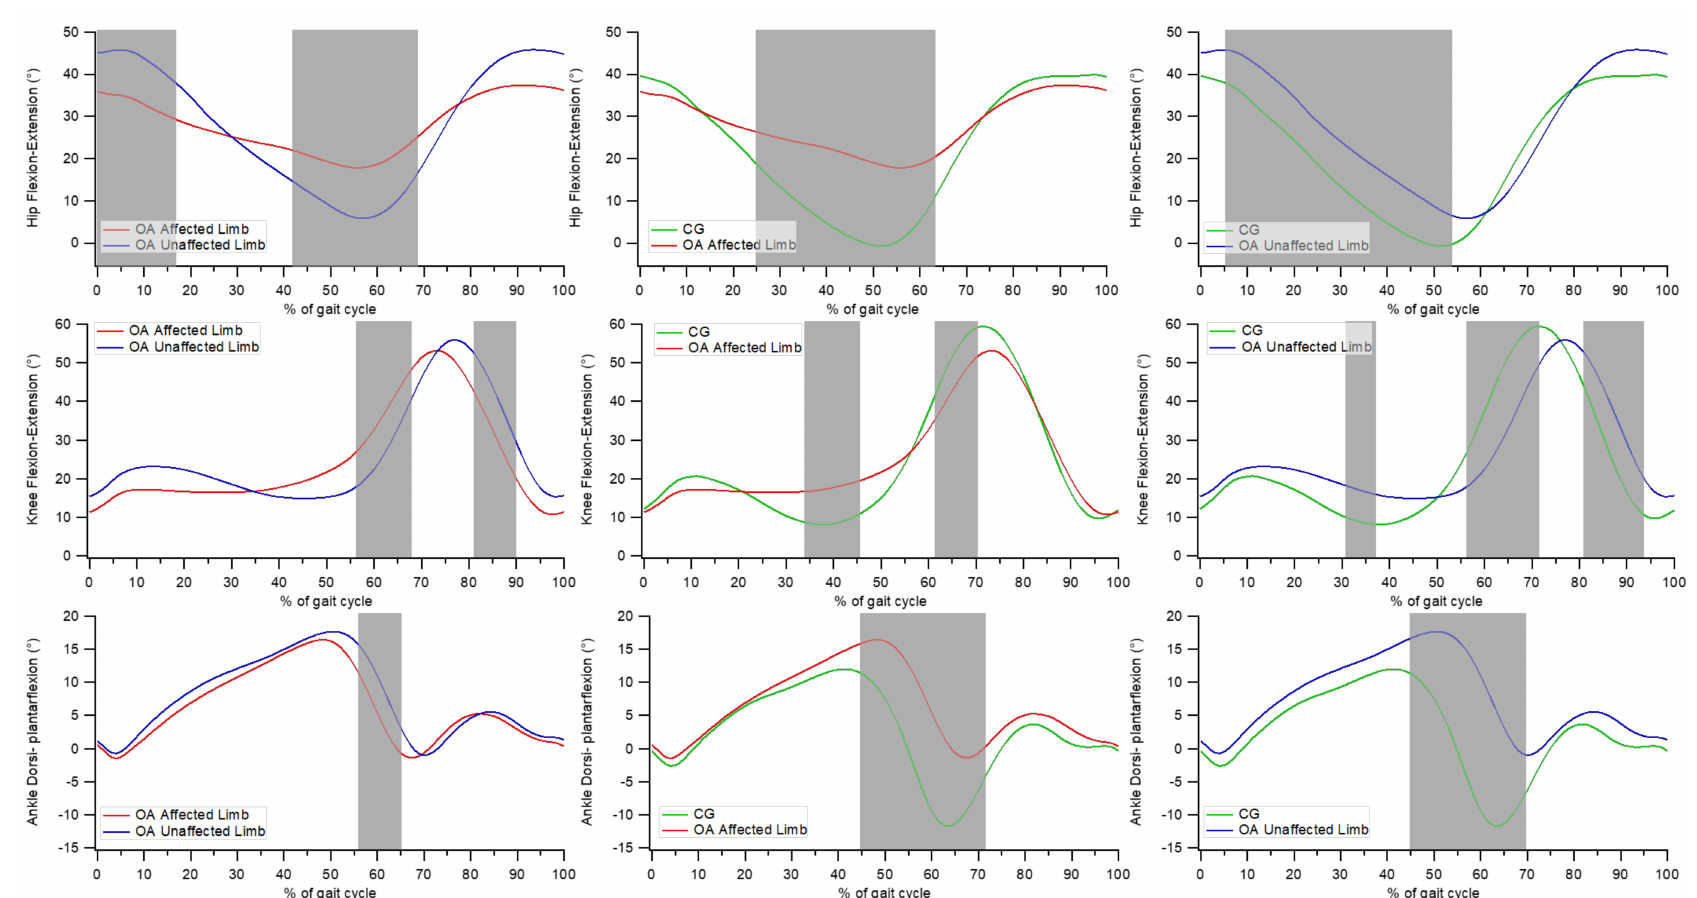
Figure 6. Gait kinematics in the sagittal plane. From top to bottom: hip flexion-extension, knee flexion-extension, and ankle dorsi-plantar-flexion angles during gait cycle. From left to right: comparison between the affected and unaffected limbs in people with OA, comparison between the affected limb of people with OA and healthy controls, comparison between the unaffected limb of people with OA and healthy controls. The grey-shaded areas denote the periods of the gait cycle in which a significant difference between the groups existed ( p <